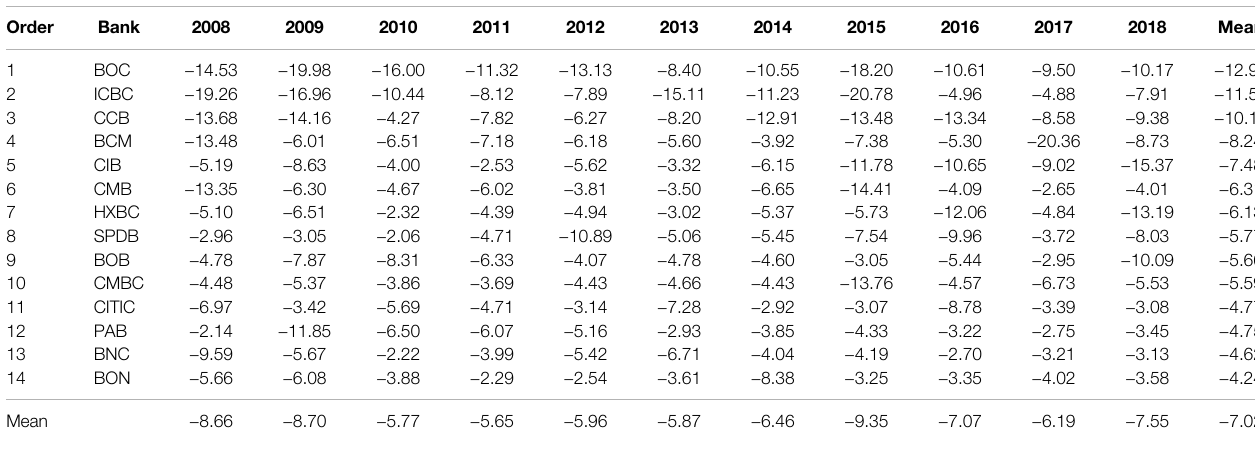
TABLE 12 | Total feedback effect of banks.